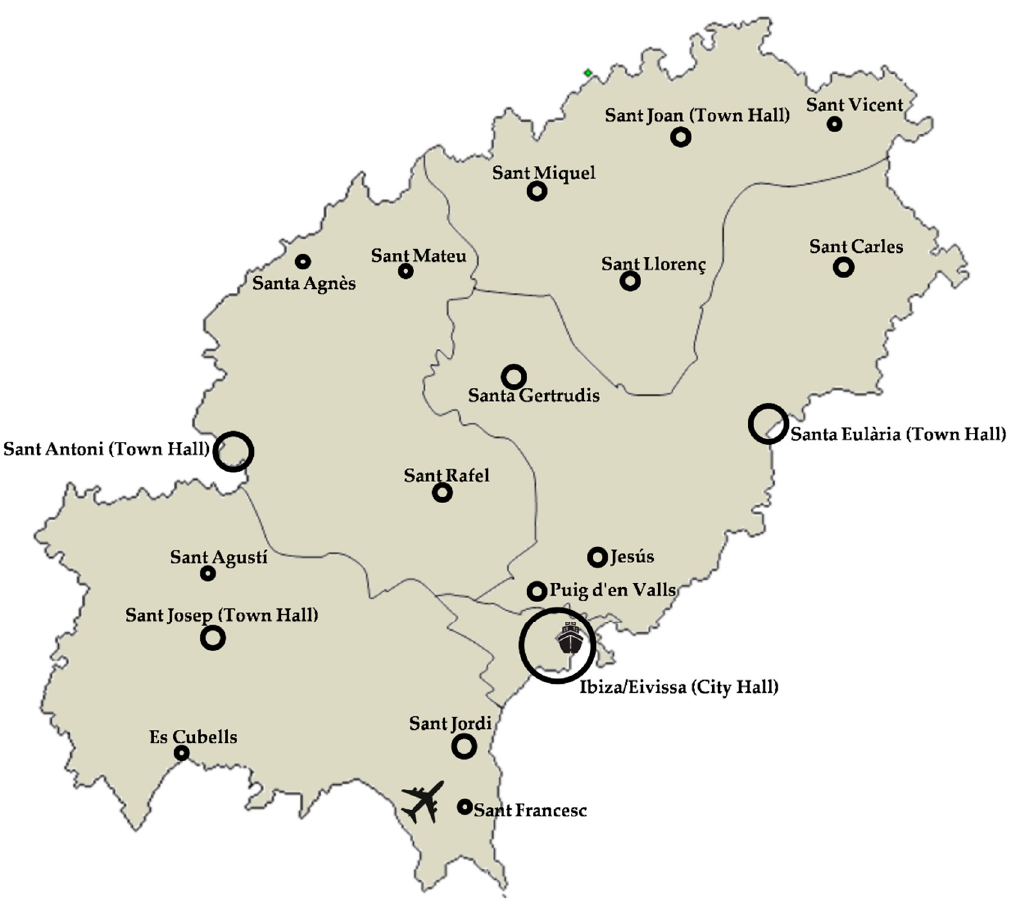
Figure 1. Political map of the island of Ibiza: municipalities and towns (own